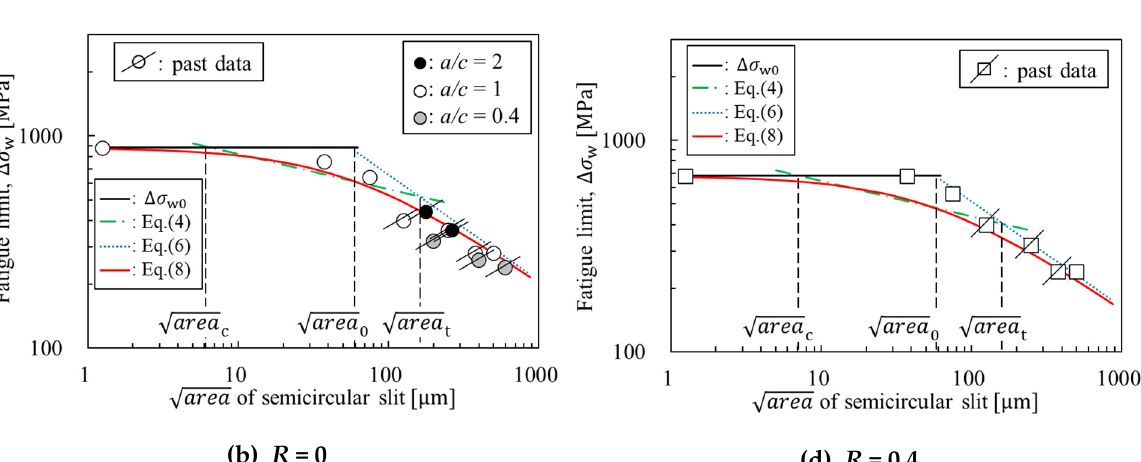
√ Figure 9. Relationship between the fatigue limit and the √(cid:1853)(cid:1870)(cid:1857)(cid:1853) for the specimens with a semicir- area for the specimens with a semicircular slit. ( a ) R = − 1, ( b ) R = Table 4 shows the values of √(cid:1853)(cid:1870)(cid:1857)(cid:1853)